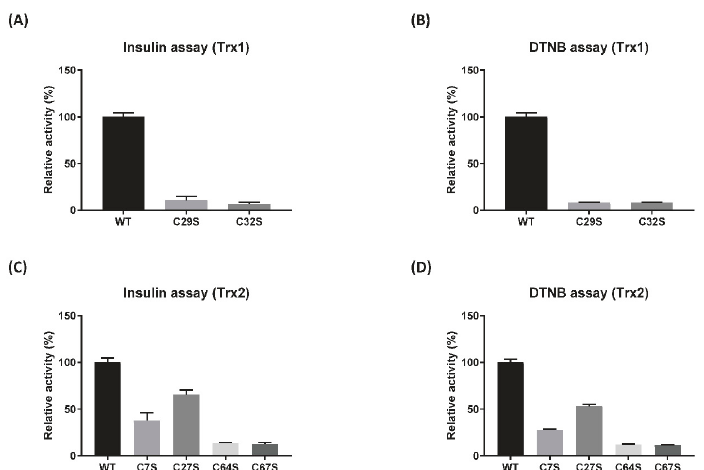
Figure 3. Effects of mutation in the conserved cysteine residues. The reduction activities of DrTrx1, DrTrx2, and its mutant proteins were compared using insulin and DTNB reduction assays coupled to the DrTrxR/NADPH regeneration system. DrTrx1 and its active site CXXC motif mutants (C29S, C32S) were used for insulin ( A ) and DTNB ( B ) reduction assays. DrTrx2 and its zinc-finger domain mutants (C7S, C27S) and active site CXXC motif mutants (C64S, C67S) were used for insulin ( C ) and DTNB ( D ) reduction assays. Relative activities of insulin and DTNB reduction of DrTrx1 and DrTrx2 are depicted as a bar graph, using the absorbance at 15 min (DTNB) and 30 min (insulin), where the activity of native DrTrx1 and DrTrx2 was set to 100%. Error bars indicate the standard deviation for three experimental replicates.